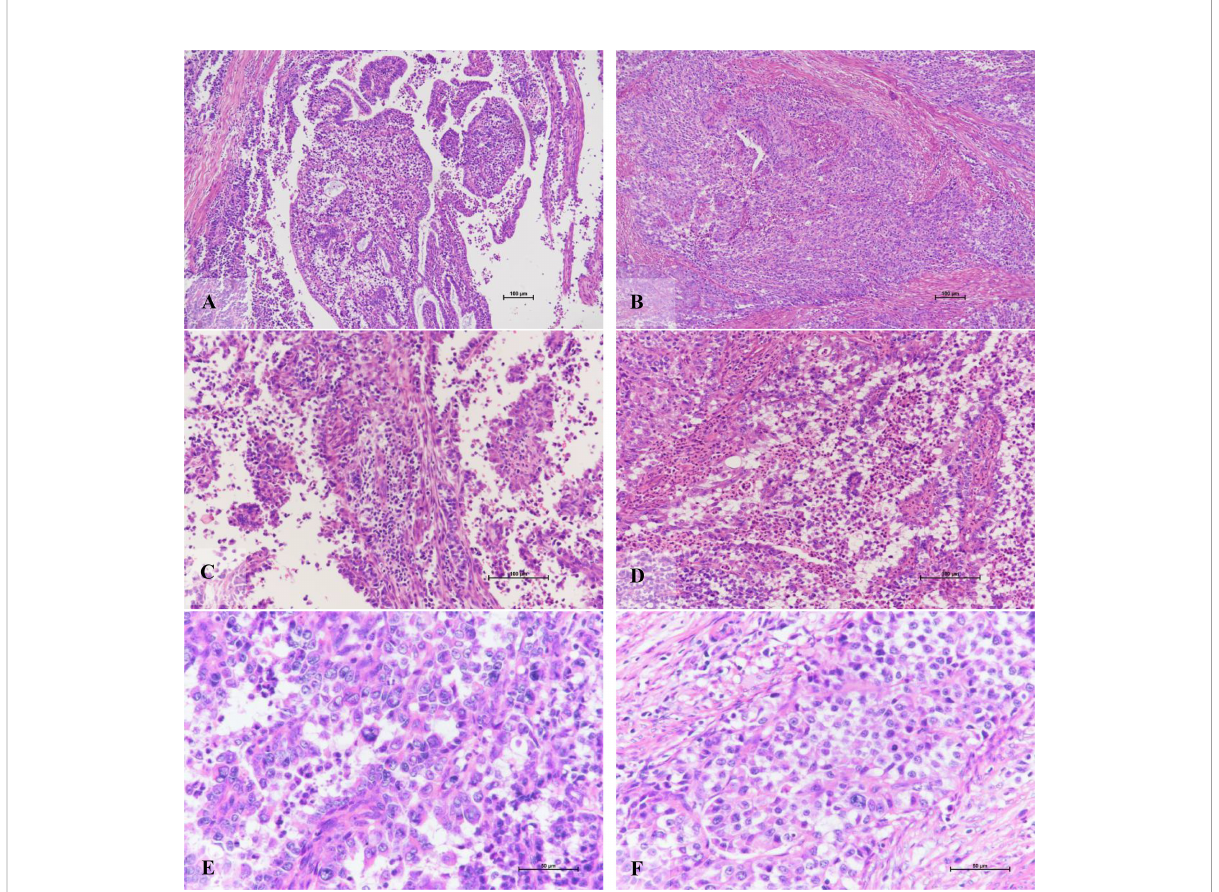
FIGURE 4 Morphological characteristics of POLE-EDM endometrioid adenocarcinoma. (A) The tumor cells grow in glandular tube and papillary shape (X100). (B) The tumor cells present a solid, nest-like muscular layer in fi ltration pattern (X100). (C) The mesenchyme adjacent to the tumor cell nest, rich in tumor-associated lymphocyte areas (X200). (D) Excluding necrotic area, tumor stroma is rich in tumor-associated neutrophil area (X200). (E, F) tumor giant cells of varying sizes and rare pathological mitotic fi gures